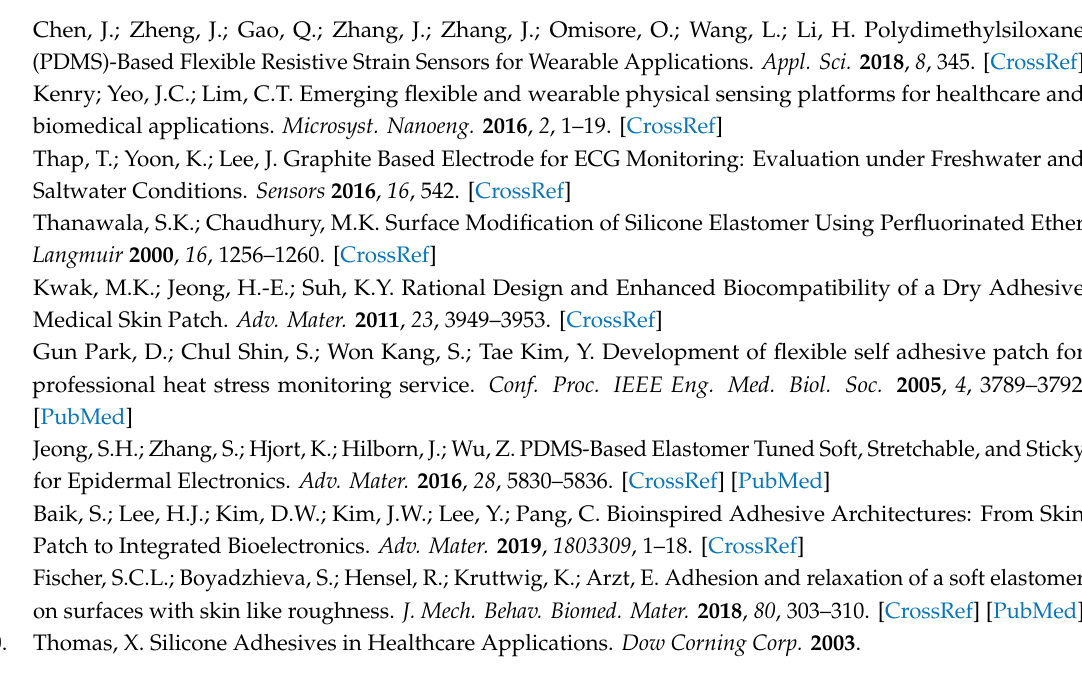
Figure S1: Schematic representation of the tack and peel measurement setup, Figure S2: Exemplary peel measurements performed with SSA patches attached to excised murine tympanic membranes, Figure S3: Cellular response to the protein coating of the elastomer films after seven days of storage in ddH 2 O before cellular seeding, Table S1: Corresponding table to Figure 4, Table S2: Corresponding table to Figure 5, Table S3: Corresponding table to Figure 6, Table S4: Corresponding table to Figure